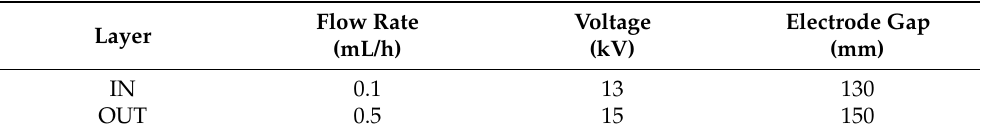
Table 1. Summary of processing parameters used for the fabrication of flat membranes from inner (IN) and outer (OUT) graft